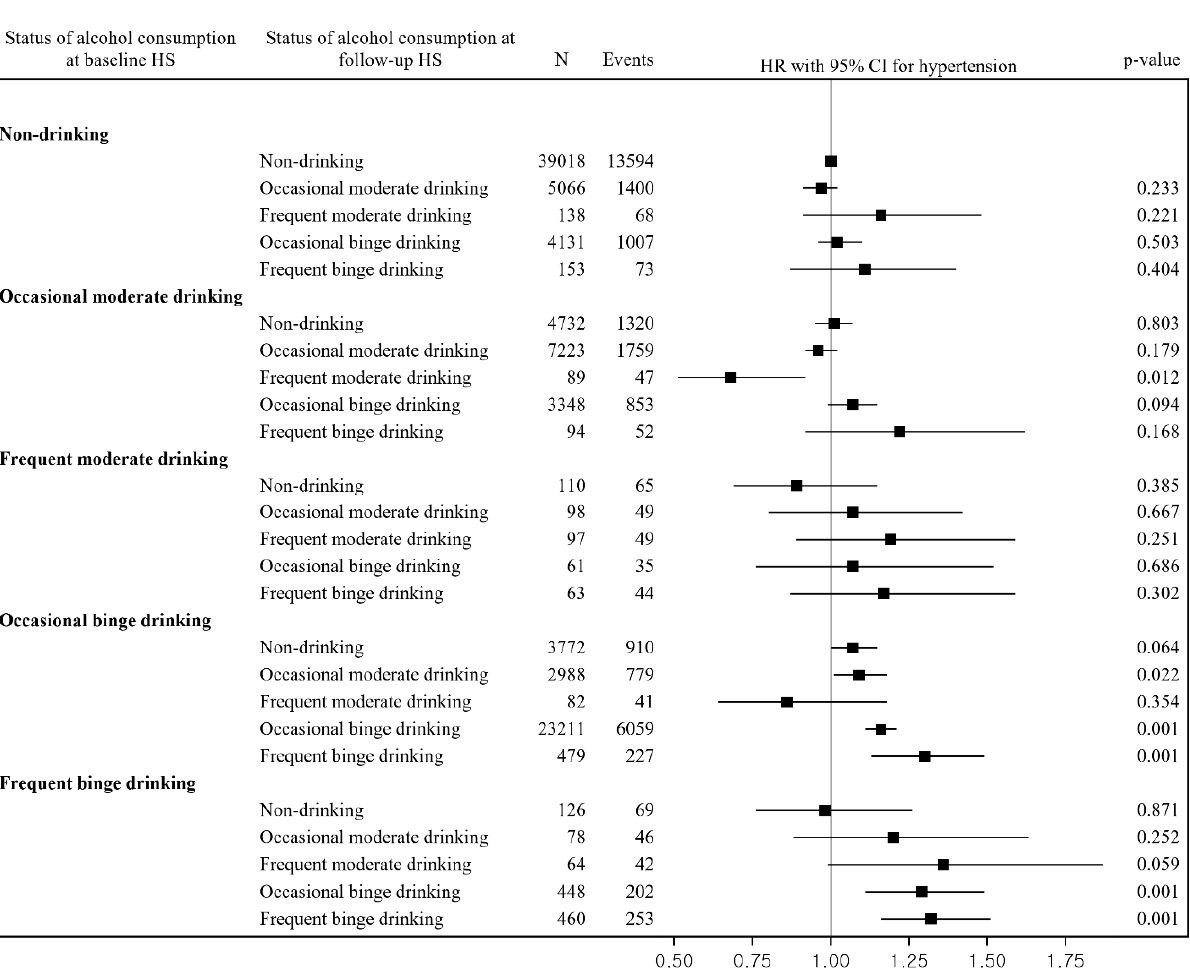
Figure 2. Relationship between changes in alcohol consumption and risk of hypertension. Abbreviations: CI = confidence interval; HR = hazard ratio; HS = health screening. The HR and 95% CI were estimated after adjusting for sex, age, BMI, systolic blood pressure, diastolic blood pressure, total cholesterol, family history of hypertension, smoking status, exercise, nutrition intake behaviors, household income, residential area, and comorbidities.